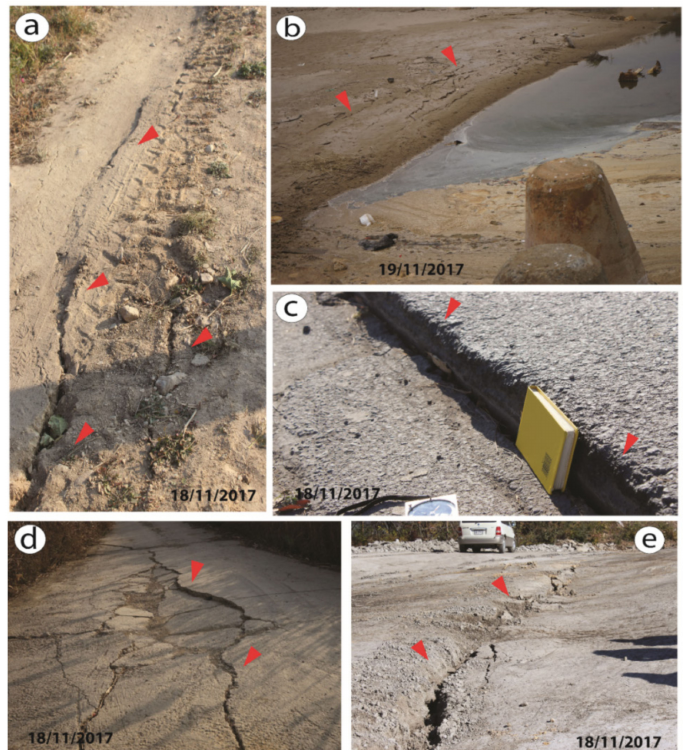
Figure 6. Field photographs showing evidence of lateral spreading observed around the epicentral area of the Pohang earthquake; ( a ) lateral spreading observed along an embankment of a canal near Yongjeon-ri; ( b ) evidence of lateral spreading along a sandy beach near Youngil Bay Port; ( c ) di ff erential settlement due to lateral spreading along a pavement road near Hangdong University; opening of cracks of an embankment near Mangcheon-ri; ( d ) series of cracks due to slope failure along a concrete road in Mangcheon-ri; and ( e ) wide openings due to lateral spreading along a reclaimed land site near Hangdong University.